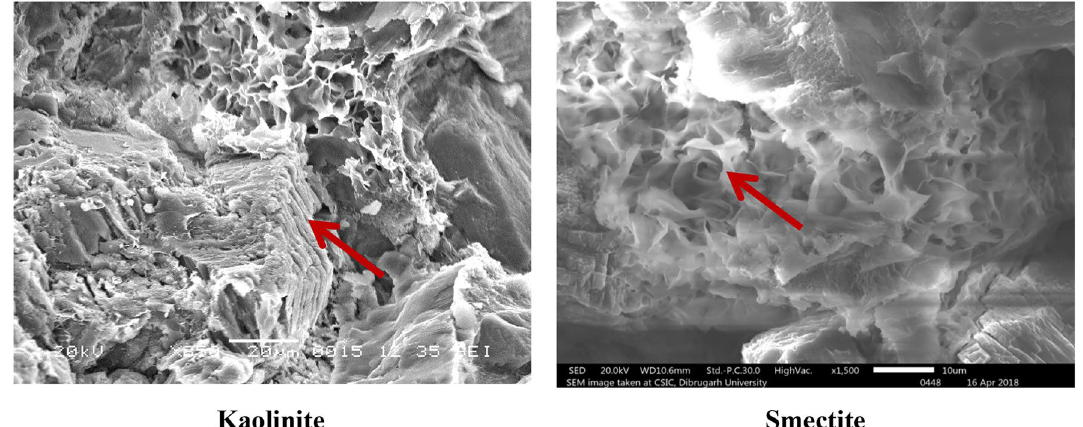
Fig. 2 SEM image of the rock